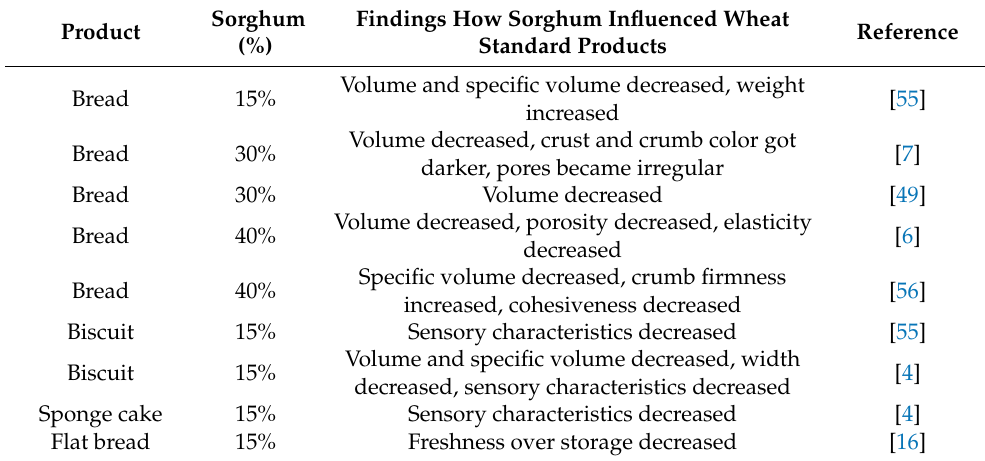
Table 2. Effects of sorghum incorporation into wheat products on selected quality